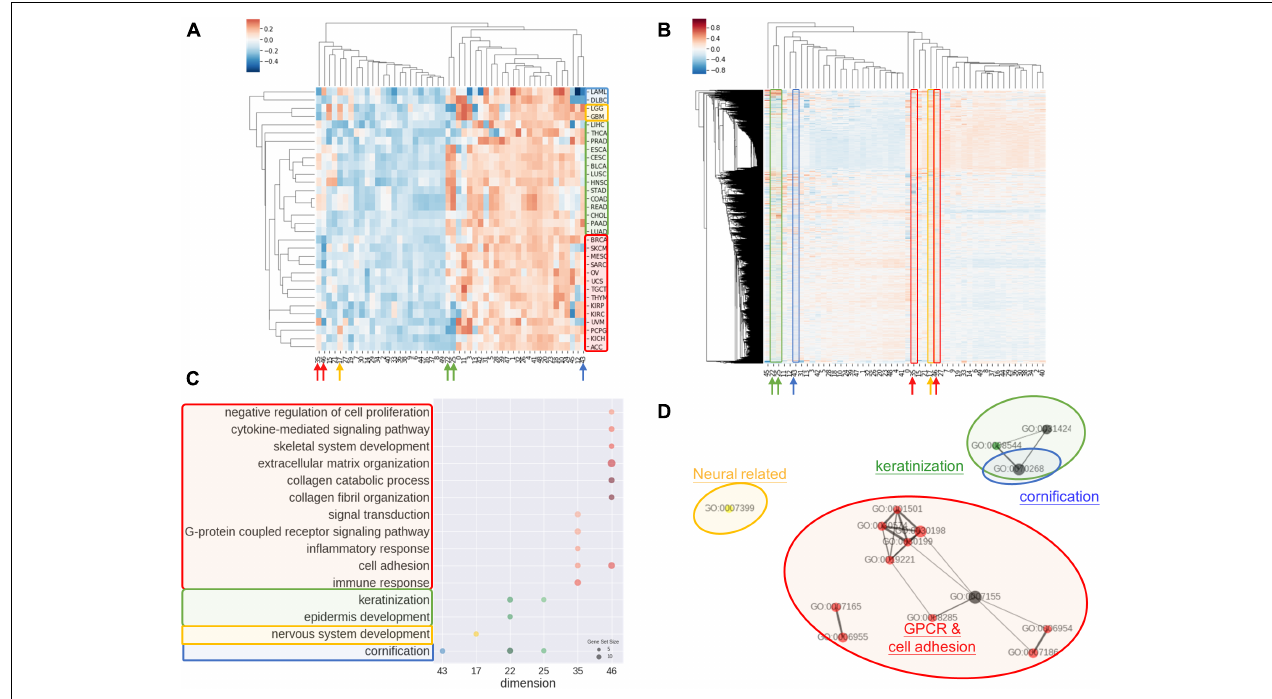
FIGURE 3 | Interpretations of entity dimension. (A) Heatmap of cancer types (corresponding centroids) with respect to entity dimensions. Cancers were clustered into at least 4 distinct groups labeled with blue, yellow, green, and red. Group blue corresponded to blood cancers, group yellow corresponded to brain cancers, group green included gastrointestinal cancers with epithelial origin, while group red consisted of cancers with mesenchymal origin. (B) Heatmap of all genes with respect to entity dimensions. Gene can correspond to more than one dimension and differentially “hot” dimension between 4 sample groups are circled and indicated by arrow. (C) Gene Ontology (Biological Process) enrichment of top 100 genes from differentially “hot”. Notably, the “hot” dimensions were associated with distinct GO terms and related to respective group. (D) Enrichment map of GO term showed three apparent clusters corresponding to respective group. Node size is proportional to gene set size; edge width is proportional to overlap coefficient, while node color is consistent to group